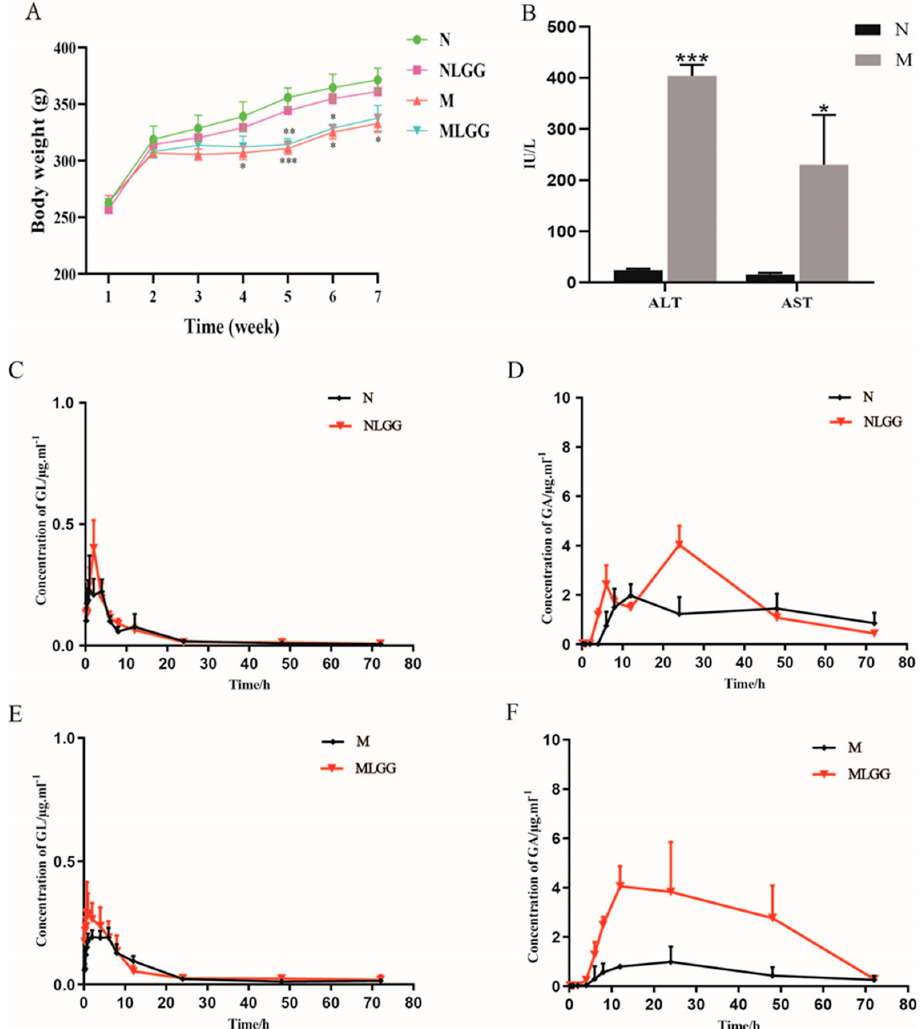
Figure 2. Lactobacillus rhamnosus R0011 ( L. rhamnosus R0011) promoted the bioavailability of glycyrrhizinic acid (GL) under liver fibrosis state. ( A ) The curves of body weight changes of the four group rats. ( B ) ALT and AST in the plasma of rats in the normal and model groups. ( C ) Plasma concentration profiles of GL treated with L. rhamnosus R0011 in the healthy group. ( D ) Plasma concentration profiles of glycyrrhetinic acid (GA) treated with L. rhamnosus R0011 in the healthy group. ( E ) Plasma concentration profiles of GL treated with L. rhamnosus R0011 in the model group. ( F ) Plasma concentration profiles of GA treated with L. rhamnosus R0011 in the model group. Data are presented as the mean ± SEM ( n = 6). The data were analyzed via Student’s t-test (* p < 0.05; ** p < 0.01; *** p < 0.001).